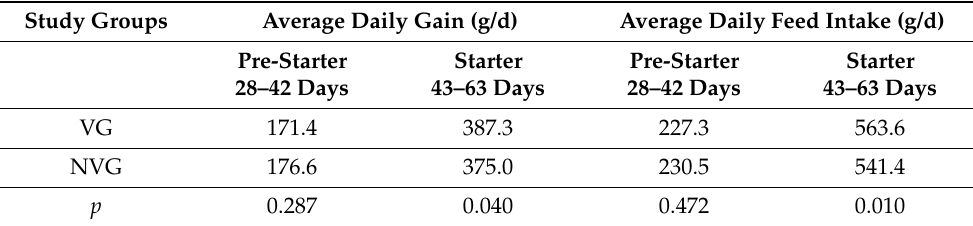
Table 4. Average daily weight gain and average daily feed intake results for the different studied